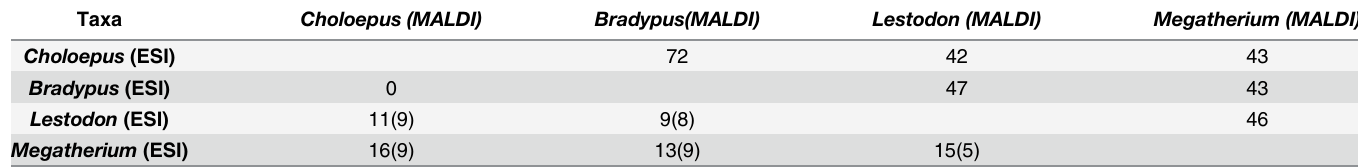
Table 1. Number of amino acid variations detected through LC-based methods compared with number of most intense 100 peaks shared in MALDI fingerprints (numbers in brackets indicate observations confirmed in both fossil replicates for each